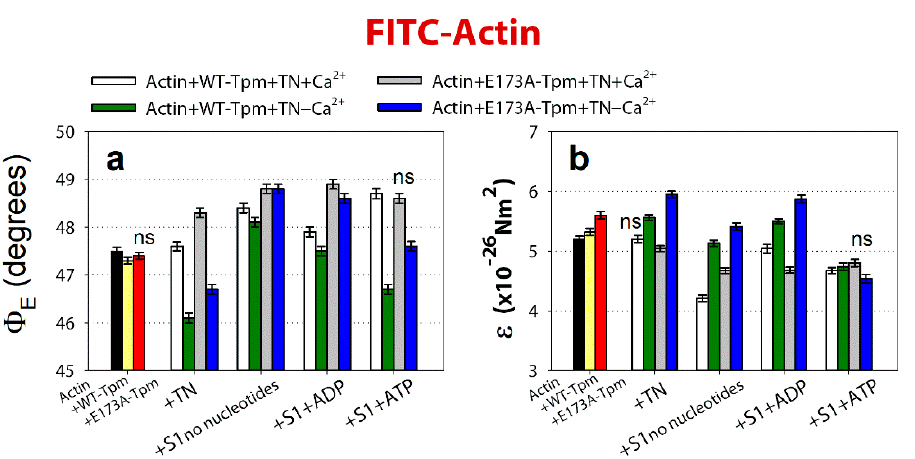
Figure 5. The e ff ect of troponin and Ca 2 + on the values of Φ E ( a ) and ε ( b ) of the polarized fluorescence for FITC-phalloidin-actin, in the presence of WT-Tpm or E173A-Tpm under conditions simulating the sequential steps of the myosin ATPase cycle. The first and second entries from the left in each panel present the data obtained in the absence of S1. The relative amount of the WT and mutant Tpms, as well as the amount of S1 in all experiments was similar in the Actin-WT-Tpm-S1 and Actin-E173A-Tpm-S1 complexes (see Section 3), suggesting that the same fraction of actin monomers bound S1 in each case. Calculations of Φ E and ε values, preparation of the fibres, their composition and the conditions of the experiments are described in Section 3. The data represent the mean values for 8–10 fibres for each experimental condition. Both in the absence and in the presence of nucleotides the Φ E and ε values for WT-Tpm and E173A-Tpm are significantly altered by troponin and Ca 2 + ( p < 0.05). Statistically insignificant di ff erences in the values of Φ E , ε and N between WT and mutant Tpms are indicated by the symbol “ns”. Error bars indicate ± SEM. The values of N were close to 0.1.